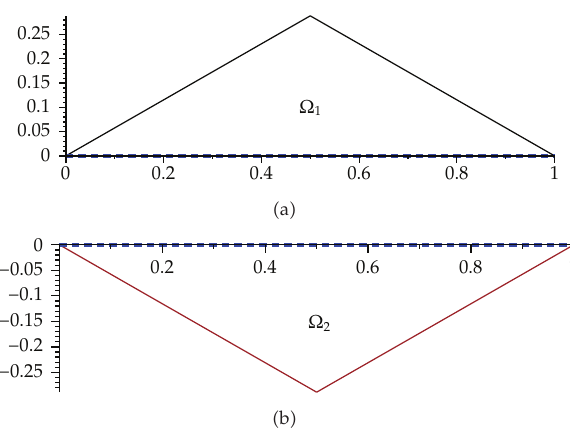
Figure 1: Areas of Ω 1 and Ω 2 : B belongs to Ω 1 ∪ Ω 2 if and only if r (cid:2) t (cid:3) has a